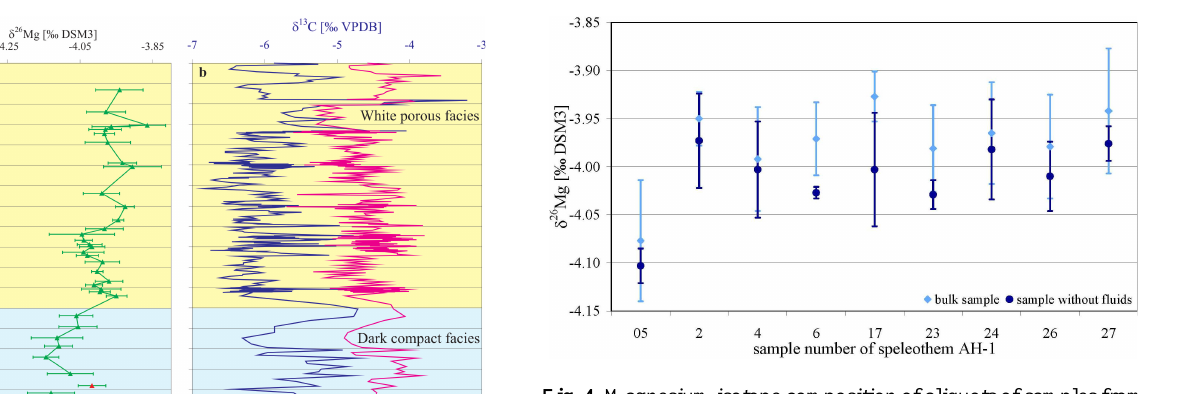
Fig. 4. Magnesium isotope composition of aliquots of samples from stalagmite AH-1. Dark blue indicates crushed samples in order to remove fluid inclusions whilst light blue indicates bulk samples. Note systematic